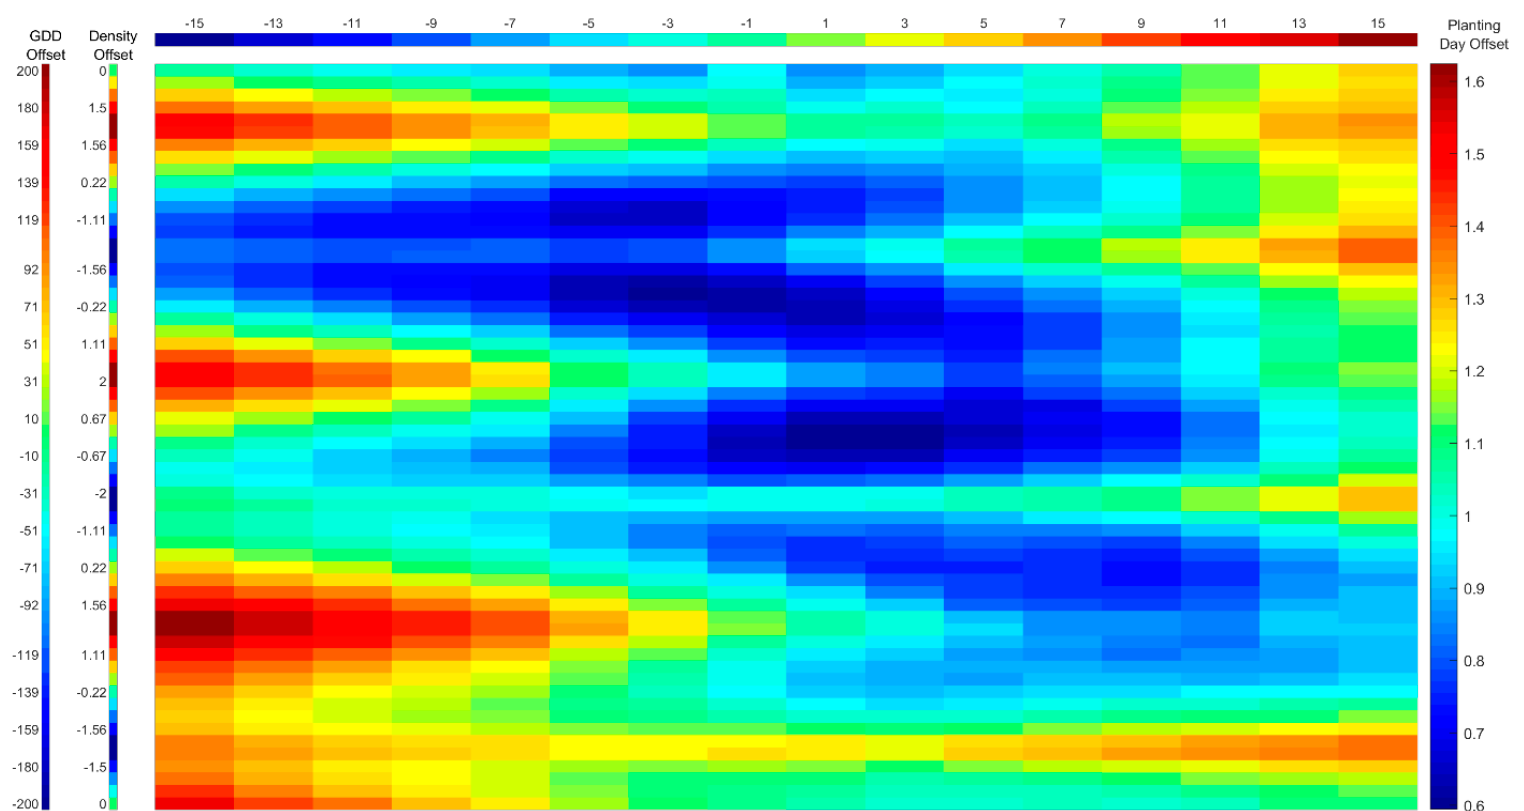
Figure 4. RMSE of modeled LAI with respect to ground-truth LAI while varying planting date, seed GDD to maturity, and planting density. Leftmost column represents offset from actual seed GDD to maturity in °C in simulation variant, while second leftmost column represents offset from actual planting density in plants/m 2 in simulation variant. Header represents offset from actual planting day in days in simulation variant. Color bar at right and color in main panel represents LAI RMSE for each simulation variant determined by column and header. N = 146.